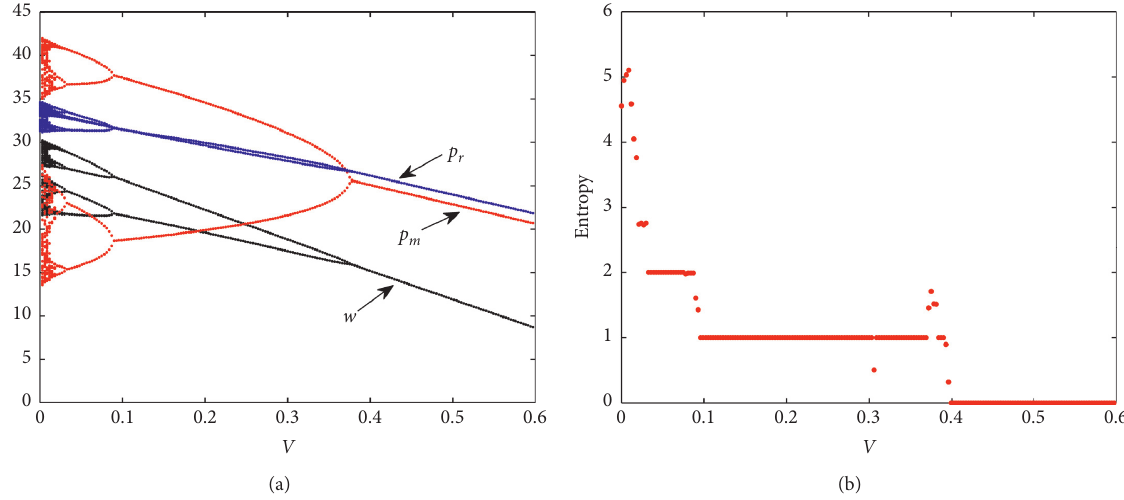
Figure 12: Bifurcation diagram and entropy with the change of v when α